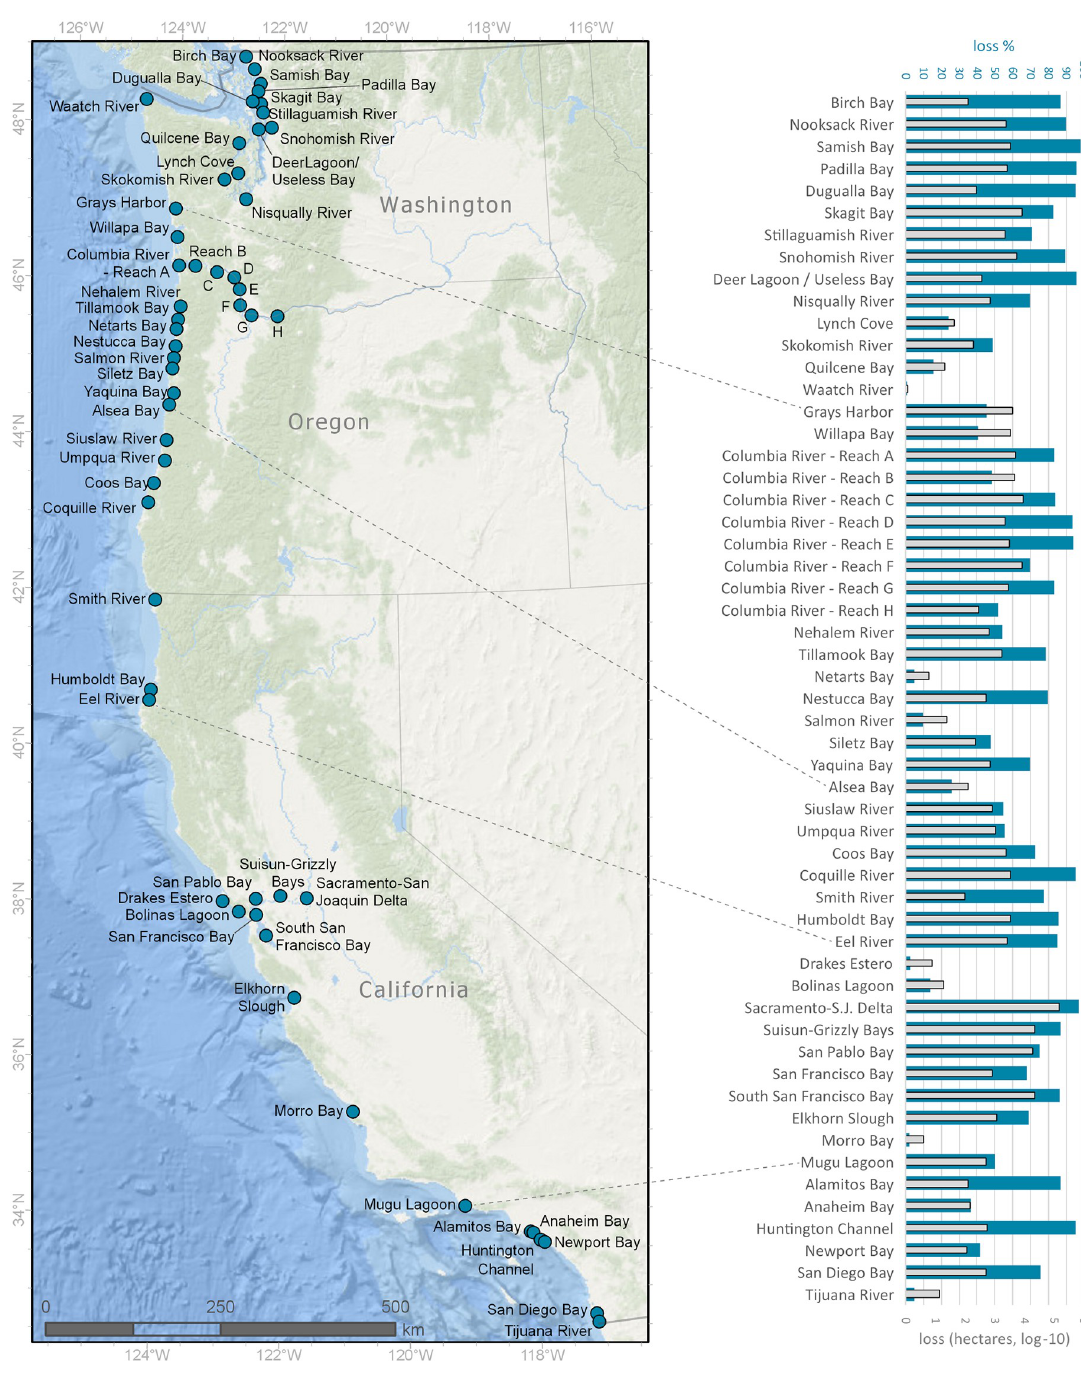
Fig 11. Wetland loss in 55 estuary systems across the Pacific Coast. The map at left denotes all estuaries used in the analysis, and the bar graph at right illustrates both % estuarine wetland loss (blue bars, top axis) and amount of loss in hectares (gray bars, bottom axis), based on indirect assessment (comparison of NWI data with